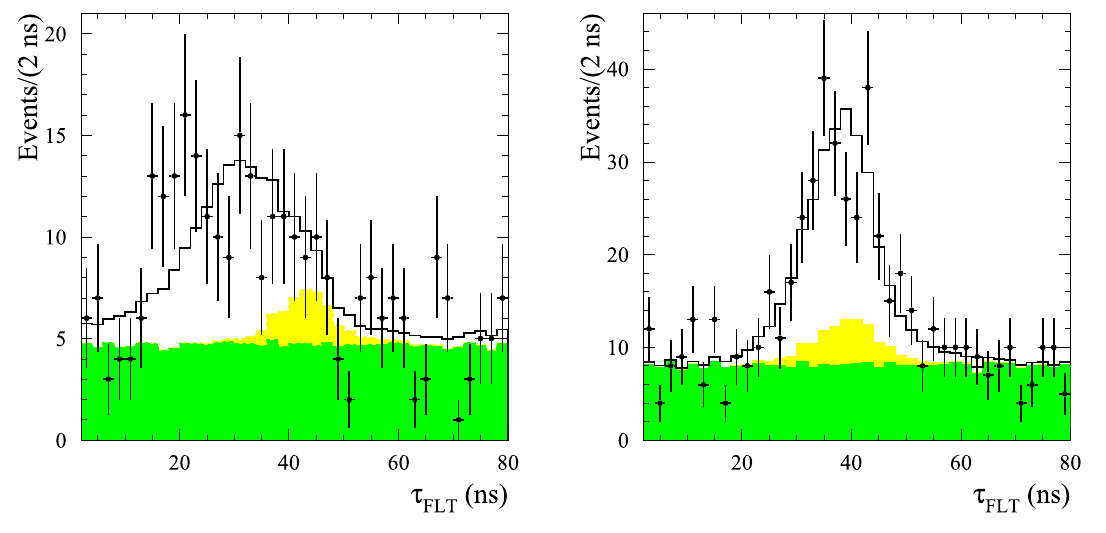
fit described in the text. The medium-shaded (green) histogram shows thefittedcosmic-raybackground. The light-shaded(yellow)region rep- resents the fitted beam-induced plus physical